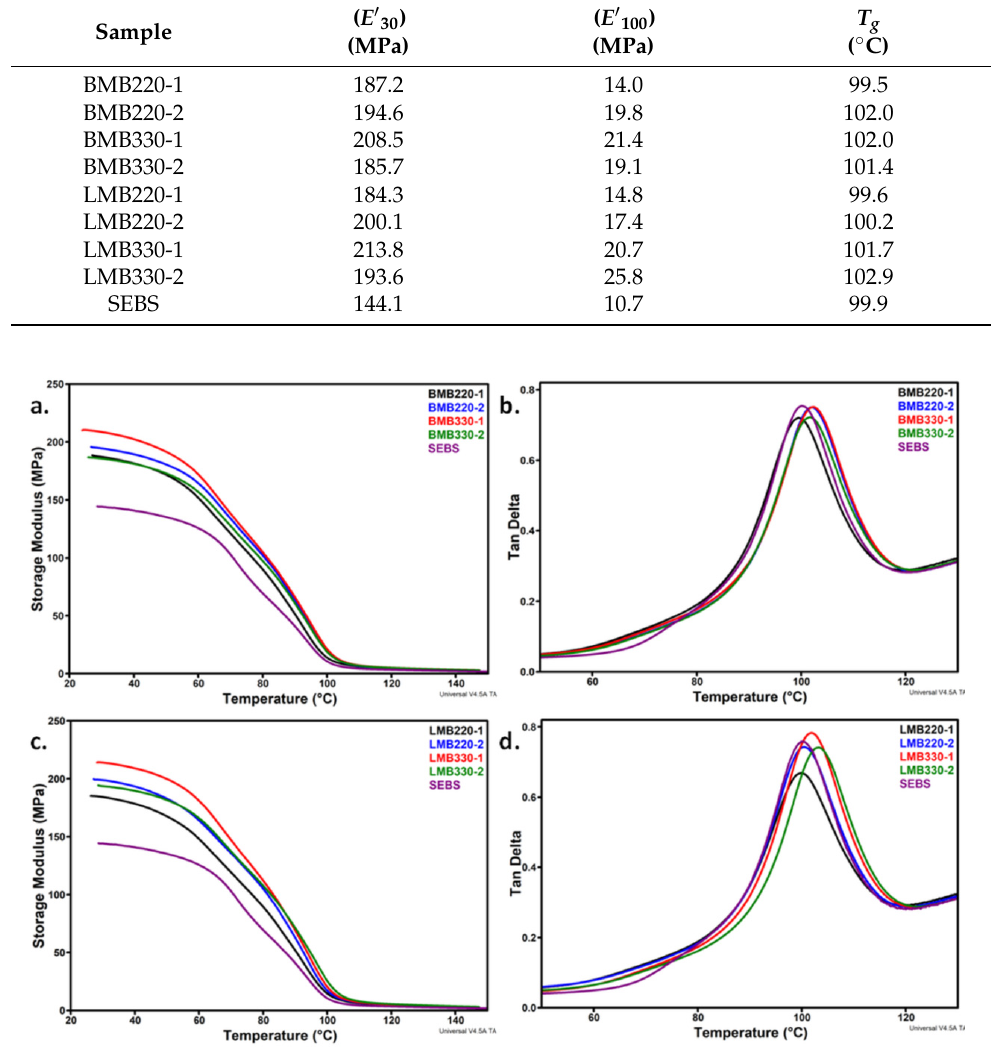
Figure 4. Storage modulus vs. temperature for masterbatches obtained with Brabender ( a ) and Leistritz ( c ) extruders; loss factor vs. temperature for BMB ( b ) and LMB ( d ) samples.